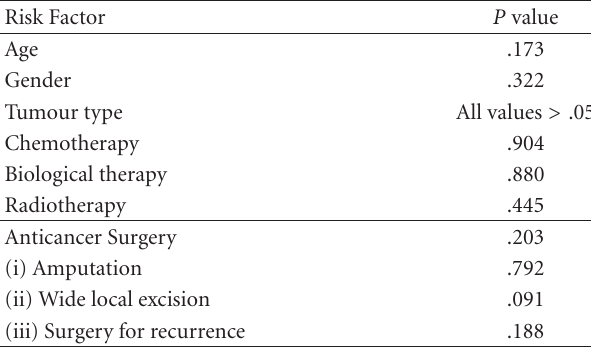
Table 4: Risk factors associated with presence of